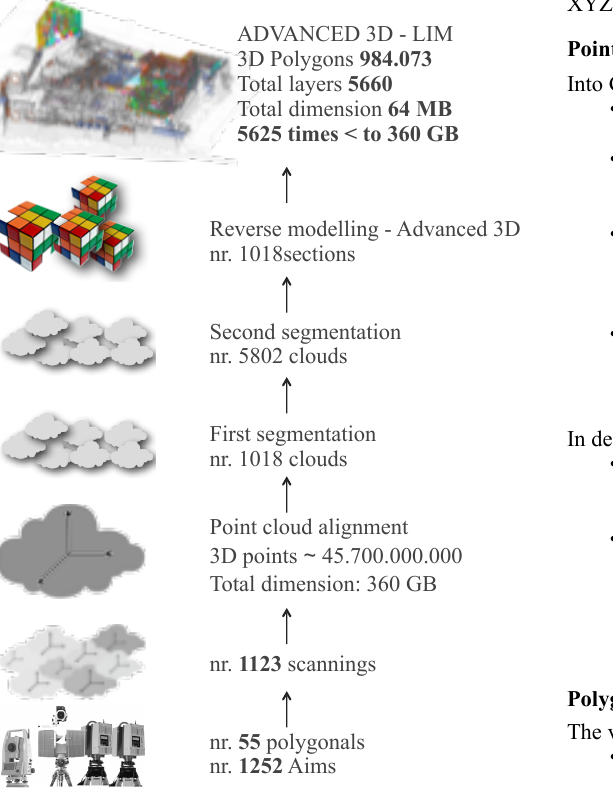
Figure 6. Advanced 3D modelling